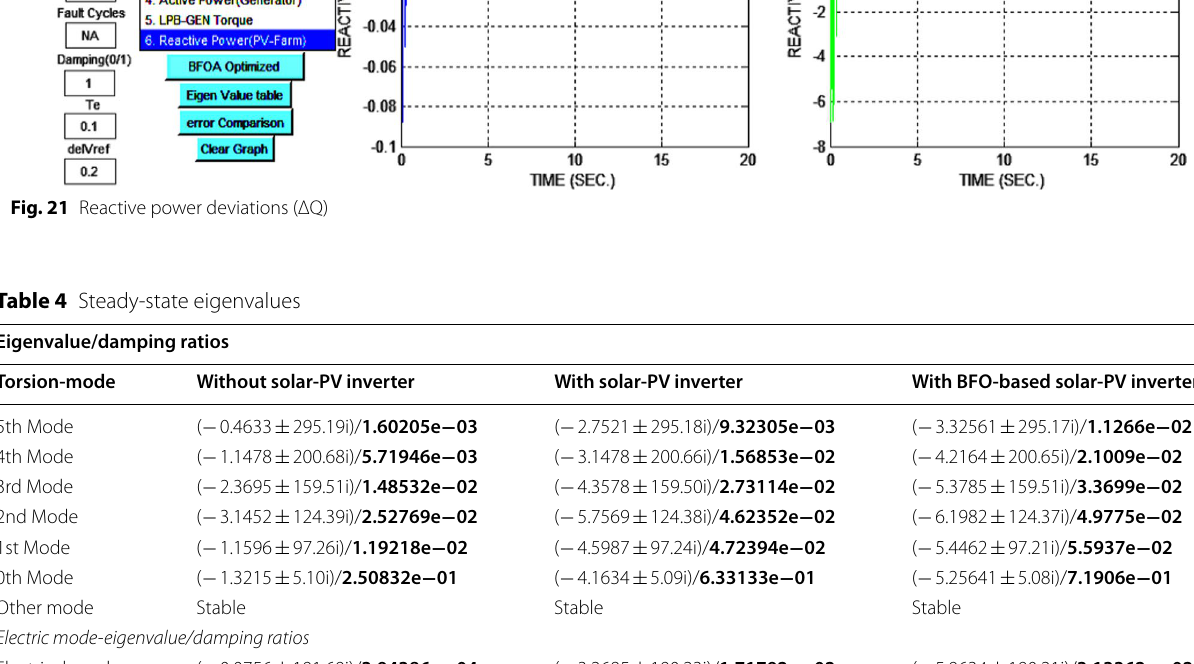
Electric mode-eigenvalue/damping ratios Bold indicates Damping Ratios